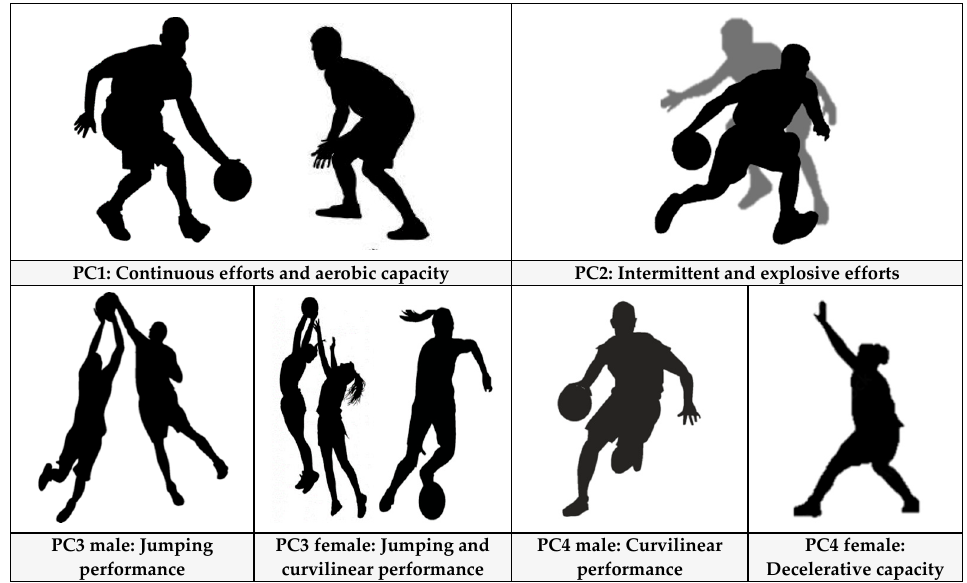
Figure 3. Representation of the principal components extracted according to the sex of the players. The first component explained 31.01% in male and 36.00% in female of total variance in basketball players. The same variables were found in both sexes that represent aerobic capacity (30–15 final players) and in-game physical-conditioning (total distance, total distance > 16 km/h, PL RT ), excepting deceleration in male and acceleration in female players during repeated sprint ability. The game dynamics of basketball requires a high aerobic capacity to repeat high-intensity intermittent efforts during offensive and defensive actions, as well as rapid coast-to-coast transitions during counterattacks [4]. Good